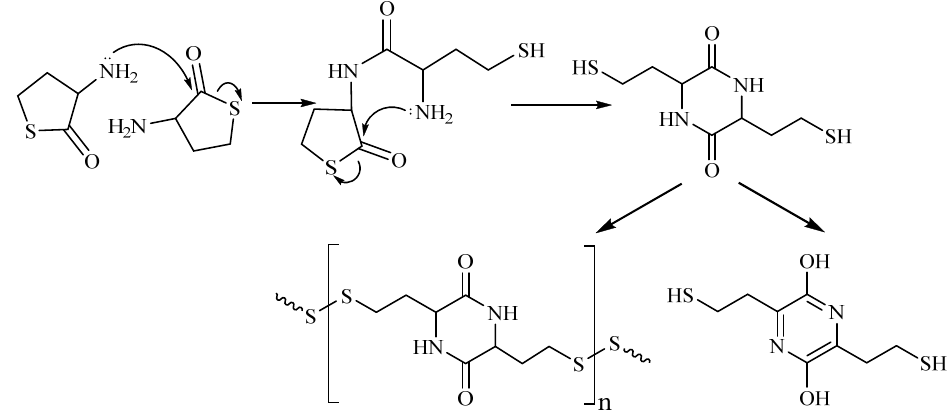
Figure 5. Opening of the HTL ring in alkali solution yielding 2,5-diketopiperazine of Hcy and subsequent transformation products.